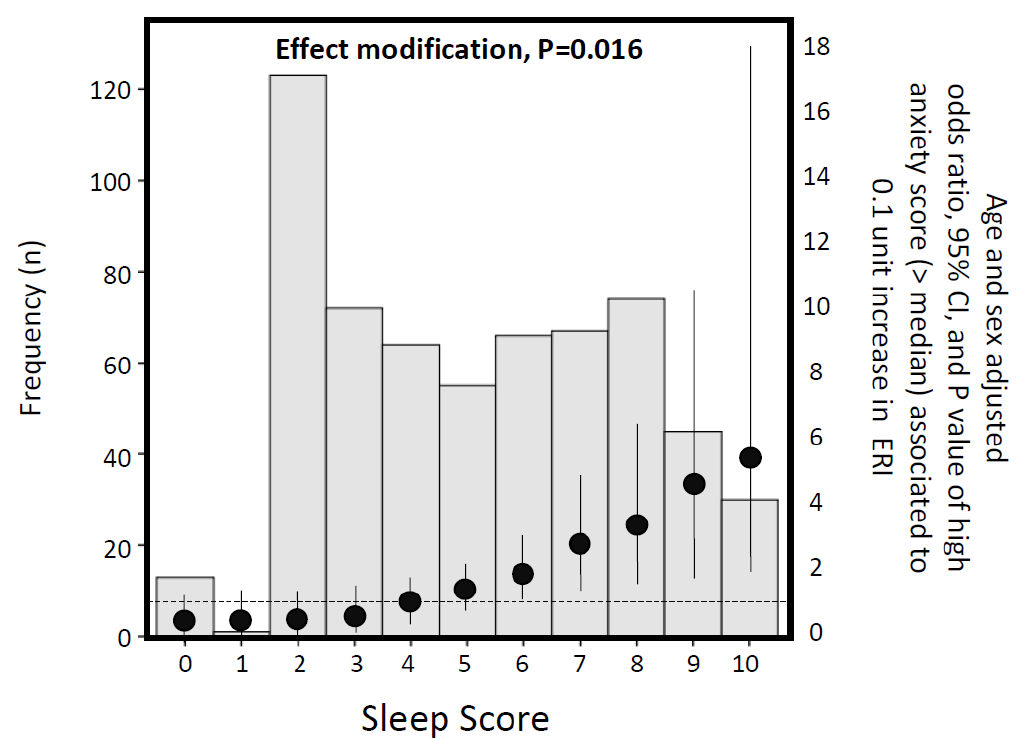
Figure 2. Histogram of the sleep score and age and sex adjusted increase of odds ratios (see black dots) and confidence intervals (95%CI) of high anxiety score (>median) associated with 0.1 increase in Siegrist’s effort / reward imbalance (effort reward imbalance) score across different values of sleep score.